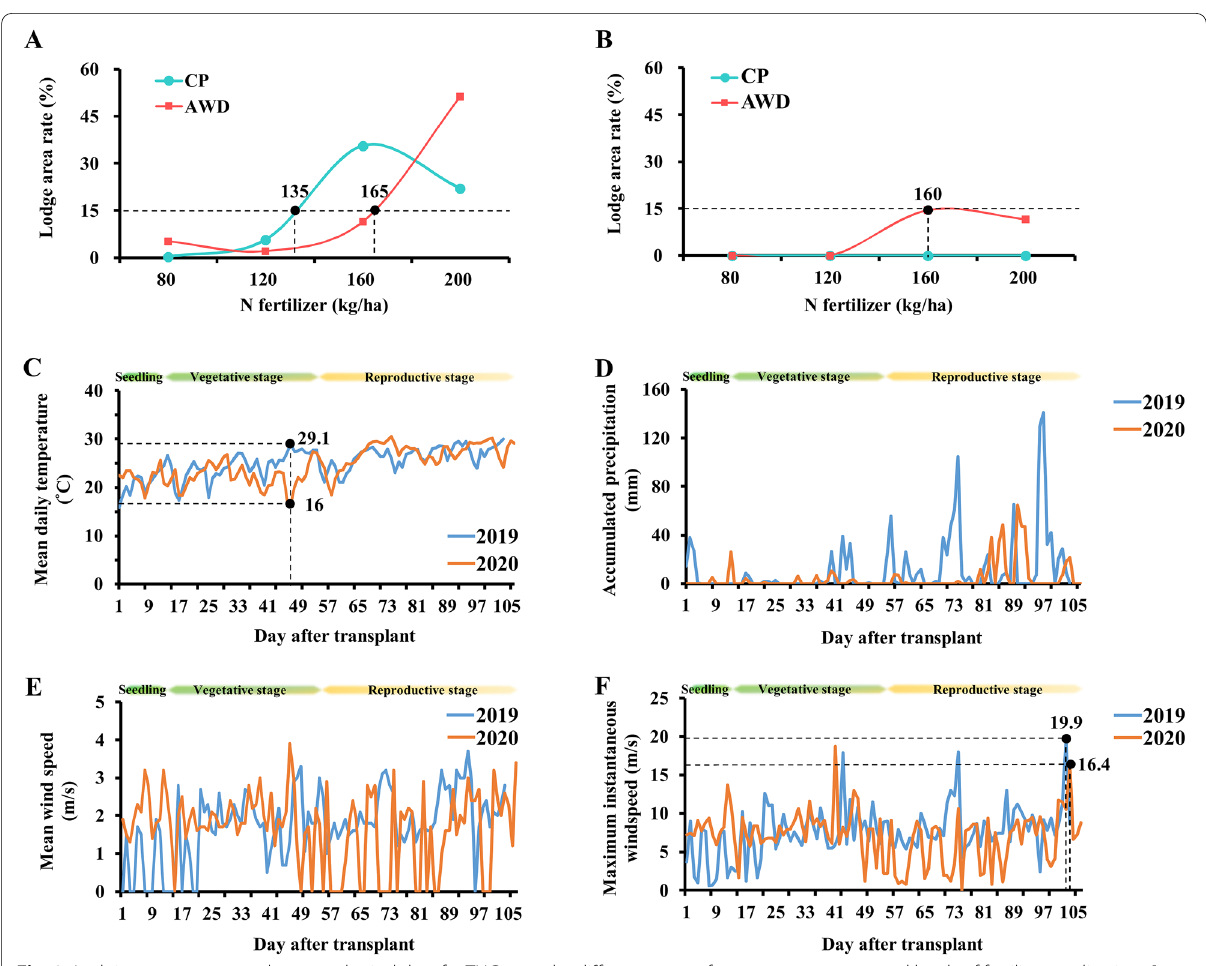
Fig. 2 Lodging percentage and meteorological data for TNG71 under different types of water management and levels of fertilizer application. A Lodging percentage in 2019. B Lodging percentage in 2020. C Daily mean temperature in 2019 and 2020. D Changes in accumulated precipitation in 2019 and 2020. E Mean wind speed in 2019 and 2020. F Maximum instantaneous wind speed in 2019 and 2020. The lodging area rate is the lodging percentage in the field. Day after transplantation was calculated from the time the seedlings were transplanted to the field. N Fertilizer treatment level is divided into 80, 120, 160, and 200 kg/ha. AWD alternative wet and dry cultivation. CP Conventional plant